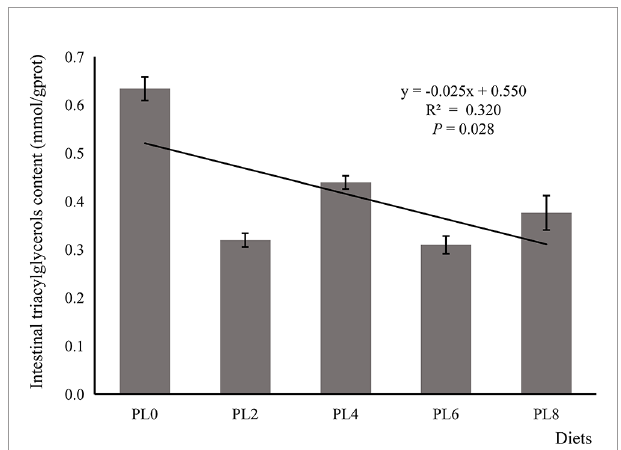
FIGURE 2 | The triacylglycerols content in intestine of larval largemouth bass fed diets with graded levels of phospholipids for 28 days. TAG: P linear = 0.028, R 2 linear = 0.320; P quadratic = 0.011, R 2 quadratic = 0.525. The “ x ” in the regression equation means the variation of dietary phospholipids